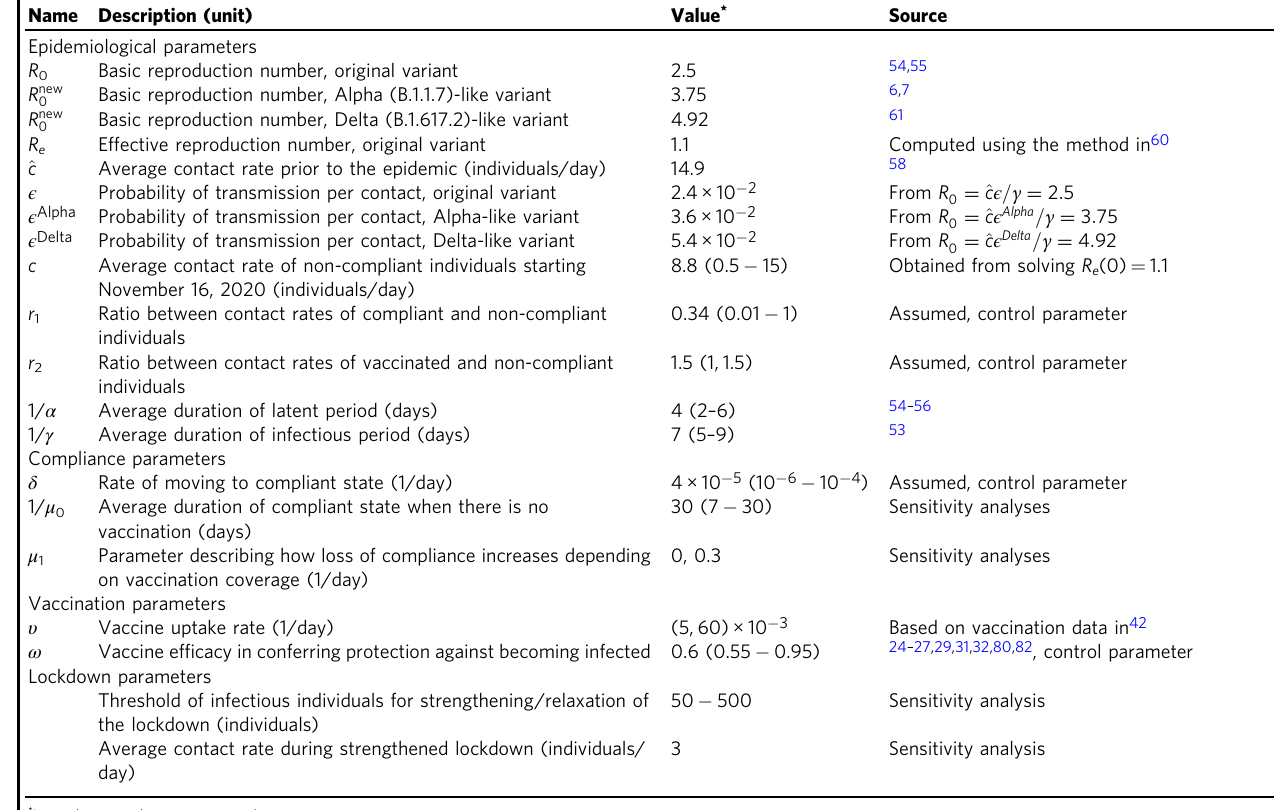
Table 1 Summary of model